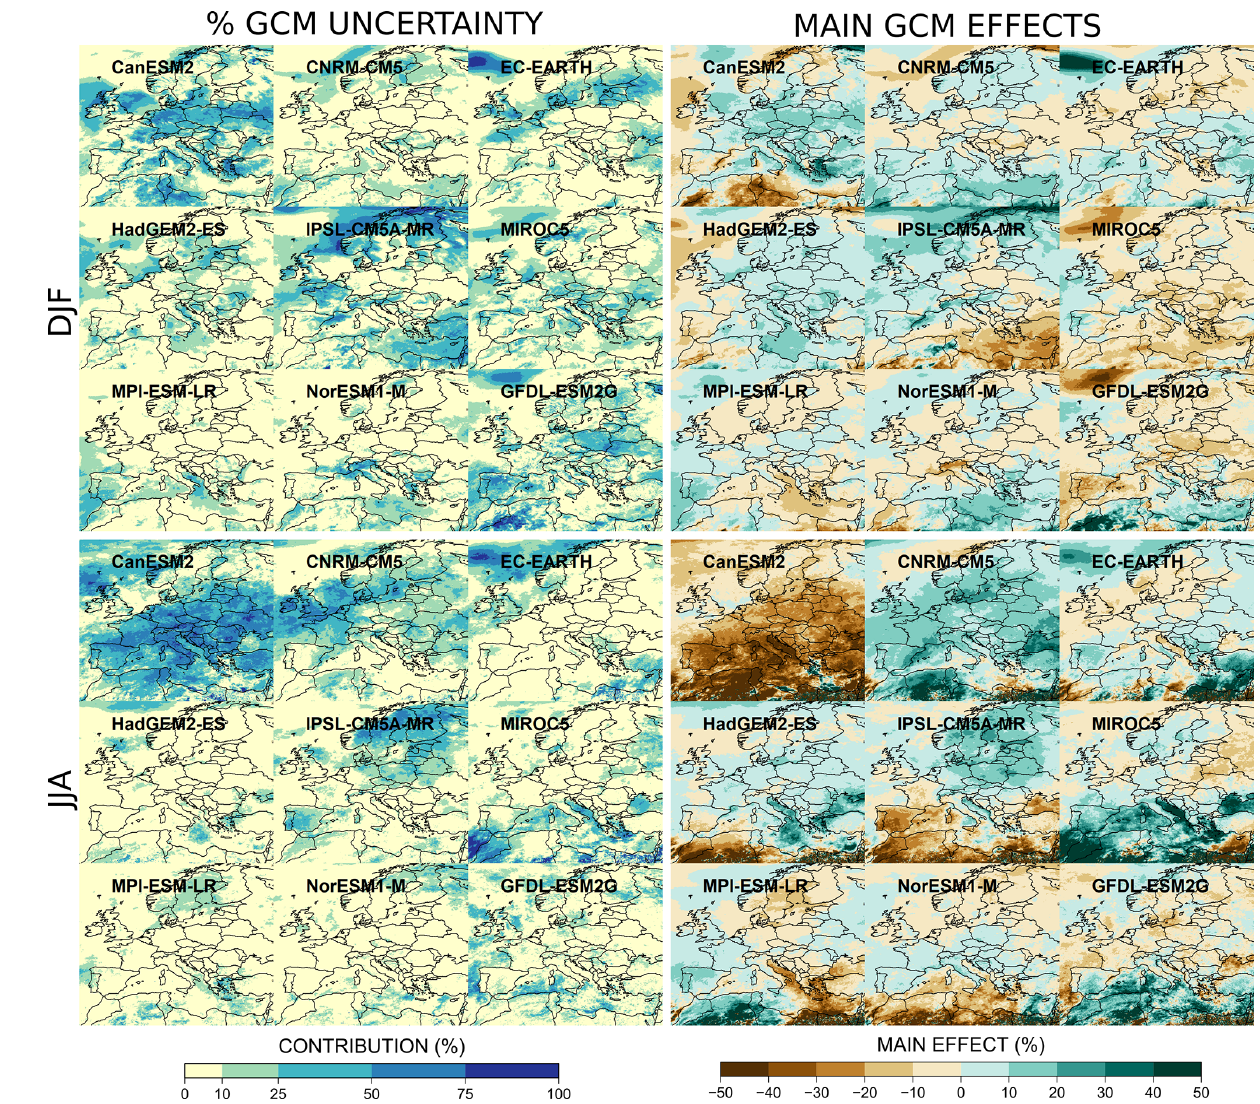
Figure 10. Fraction of GCM uncertainty (left plots) and main GCM effects (right plots) for each GCM for relative precipitation changes in winter (DJF) and summer (JJA) at the end of the 21st century (2071–2099) compared to the period